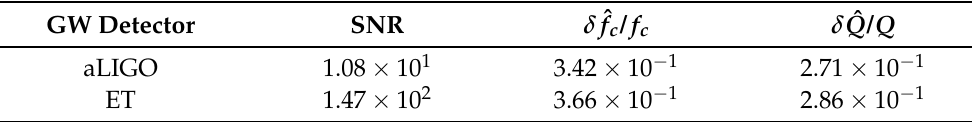
Table 3. Parameter estimation errors of the central frequency f c and the quality factor Q of the GW190521-like remnant BH using only the ringdown GW signal. The errors are normalized to the signal-to-noise ratio (SNR) of each corresponding detector.